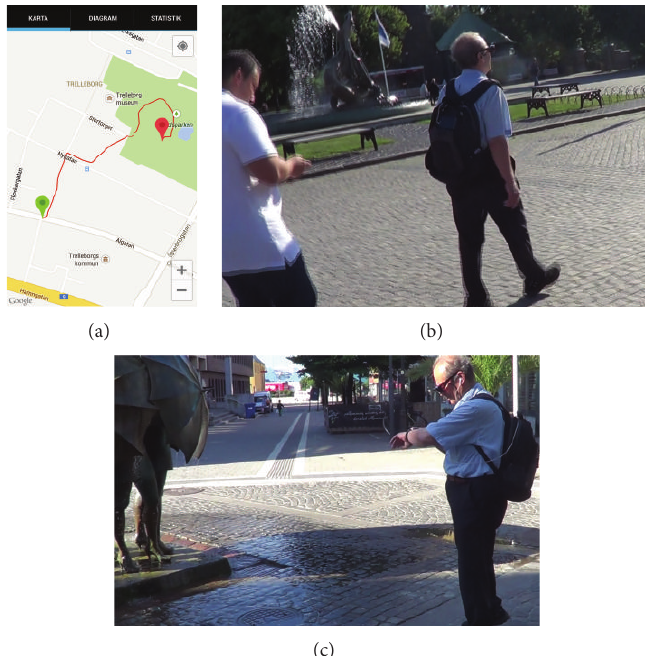
Figure 5: Three samples of what was shown during the city tour.